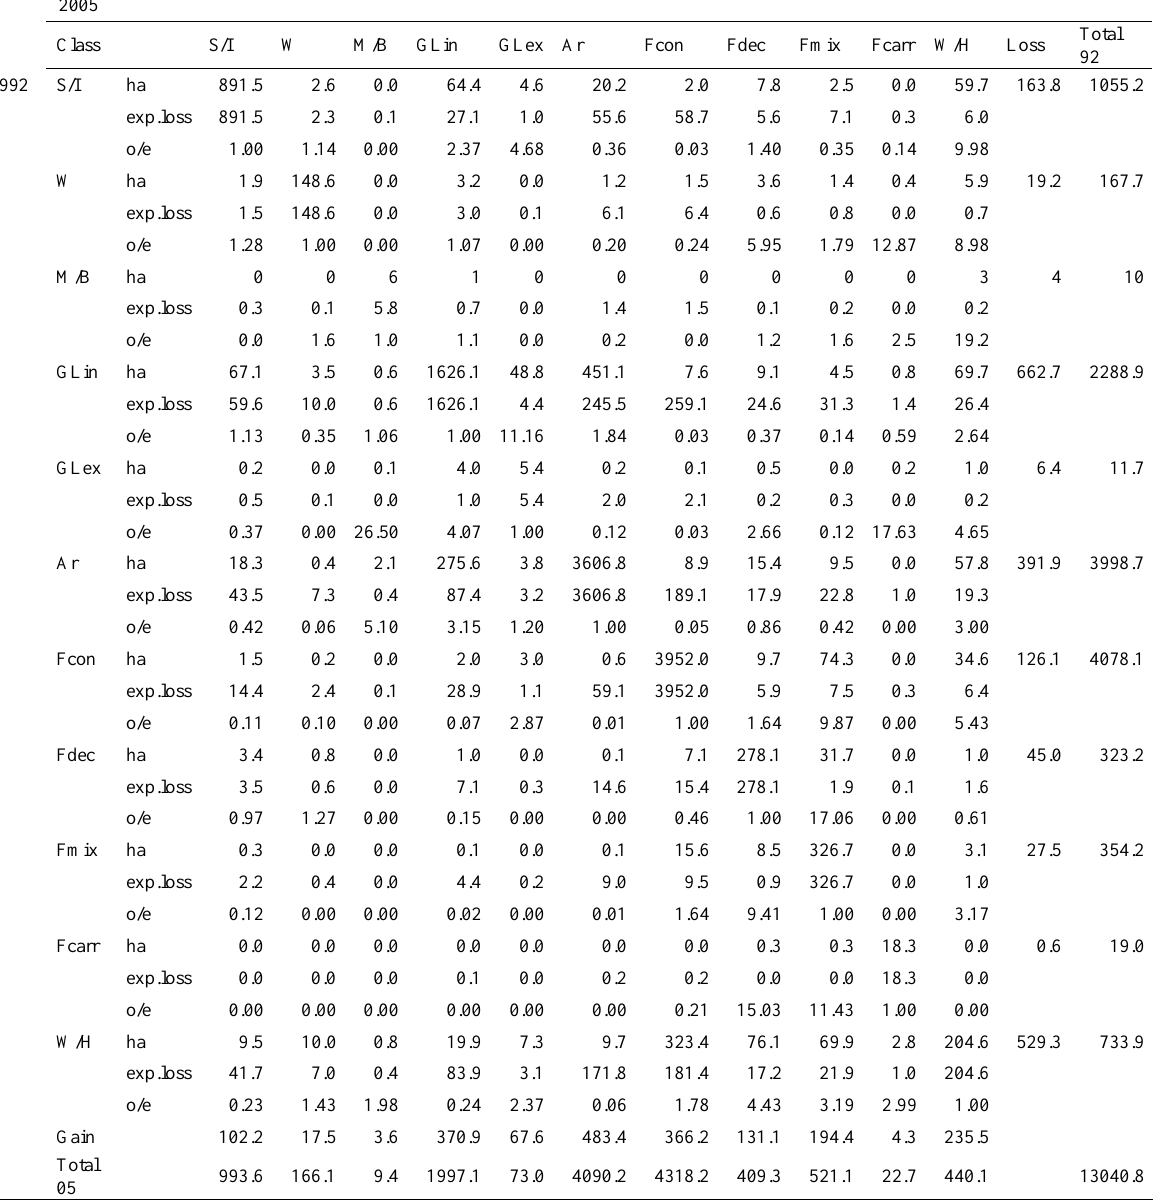
Table A1.5: Transition